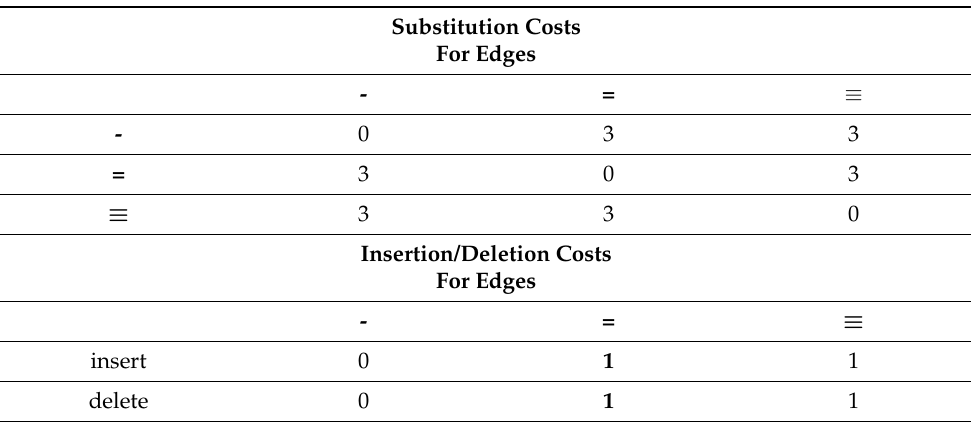
Table 4. Substitution, insertion and deletion costs for edges proposed by Harper et al.